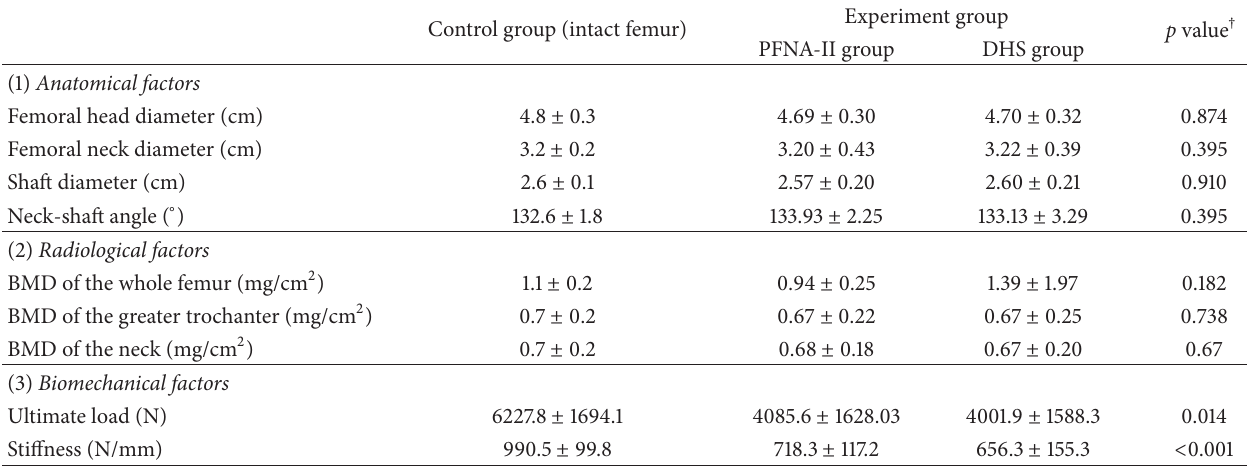
Table 1: Anatomical, radiological, and biomechanical data of the PFNA-II and DHS